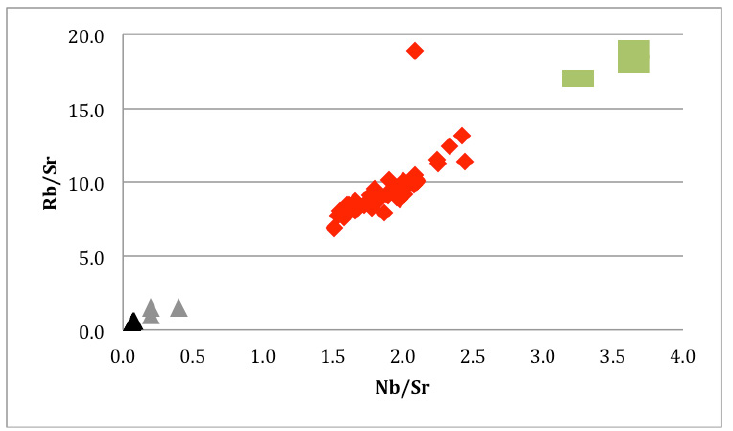
Figure 2f. Rb/Sr vs Nb/Sr. Stromboli: red diamonds; Glasgow Melos collection: black triangles; Acquafredda et al. (2018, fig. 5, tab. 1) Melos collection: grey triangles; Acquafredda et al. Lipari collection: green